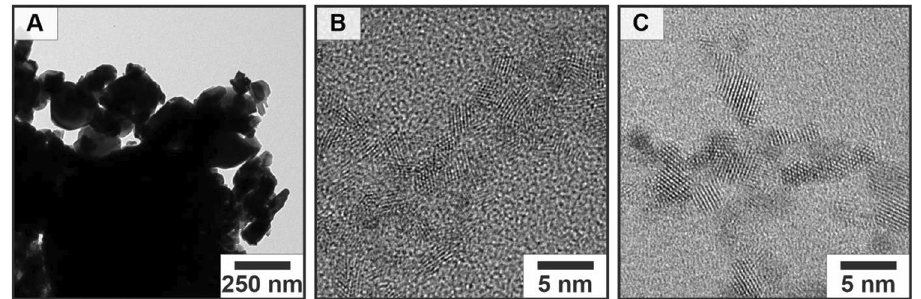
Figure 1. ( A ) TEM image of commercial CeO 2 . HRTEM images of CeO 2 NPs obtained by non-aqueous sol–gel chemistry. ( B ) NPs obtained from batch chemistry and ( C ) under segmented flow conditions. Commercial CeO 2 is produced by a gas-phase condensation process in which particles that are still hot are collected in a container. In this process, the hot particles sinter together and form large agglomerates, which do not form stable dispersions of isolated particles. In addition, no monodisperse particles are obtained in this type of mass production. Dispersions of polydisperse particles and large aggregates show strong light scattering and lead to cloudy opaque films after embedding in